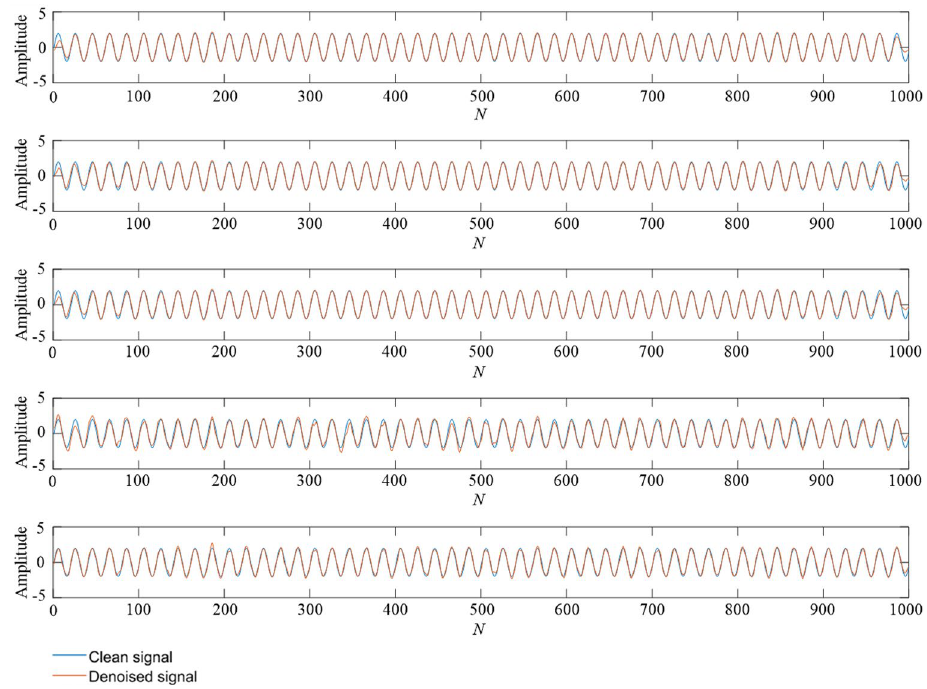
Figure 4. A comparison of denoising effect comparison under 10 dB. From top to bottom: ( 1 ) TS-WOA-VMD- CA-WT; ( 2 ) WOA-VMD-CA-WT; ( 3 ) TS-VMD-CA-WT; ( 4 ) EMD-CA-WT; ( 5 )